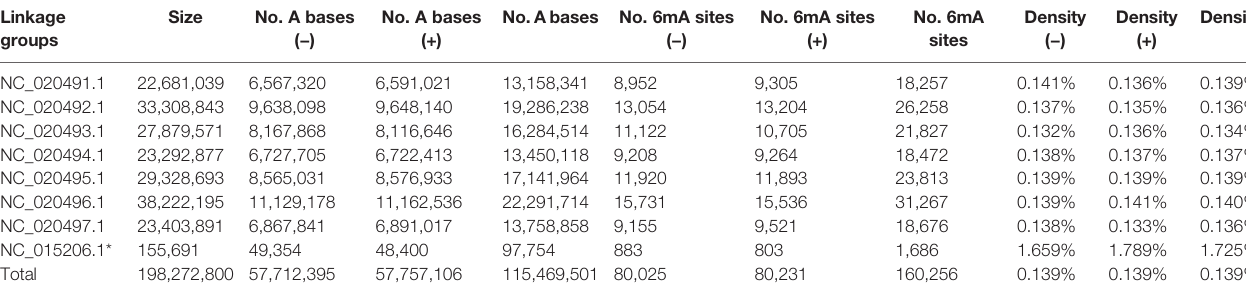
TABLE 1 | Density of N 6 -methyladenine (6mA) across the Fragaria vesca genomic DNA. Linkage